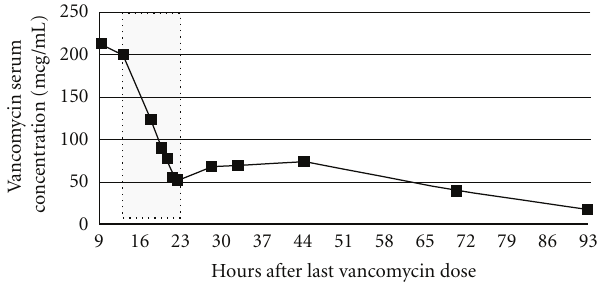
Figure 1: Concentration-time curve of vancomycin in a 7-year-old child. Initial concentration was collected nine hours after a dose. Shaded area indicates time of active high-flux hemodialysis therapy. Total dialysis time = 6